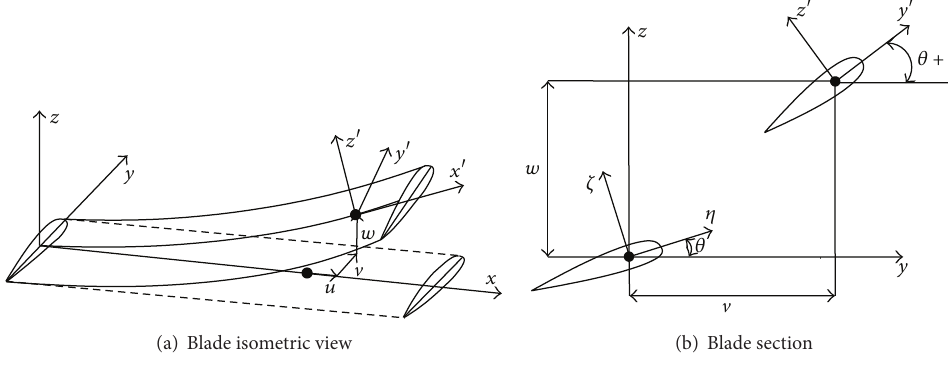
Figure 2: Rotor blade coordinate systems and displacements.